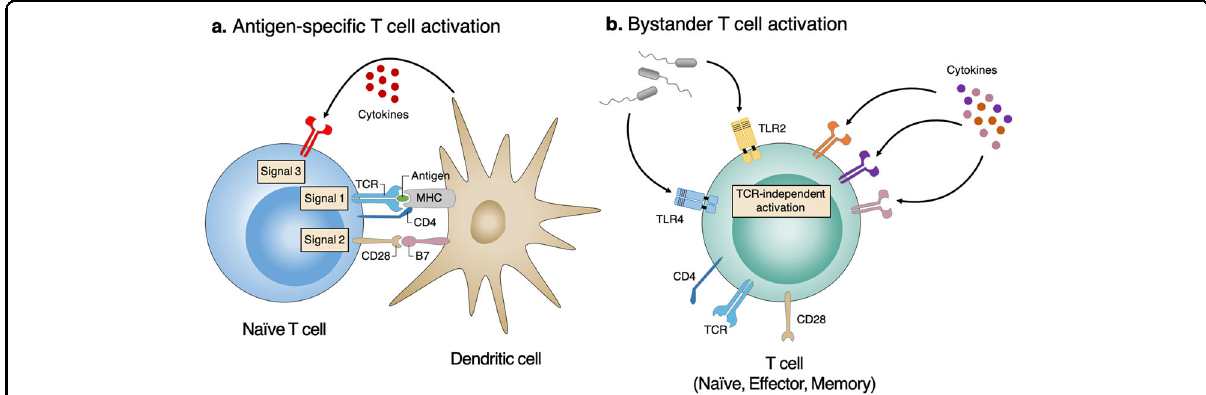
Fig. 1 Antigen-speci fi c vs. bystander T-cell activation. a Antigen-speci fi c T-cell activation requires three distinct signals. Signal 1 is antigen-speci fi c signaling mediated by T-cell receptor (TCR) engagement of pathogenic peptides presented by major histocompatibility complex (MHC) molecules. Signal 2 is costimulatory signaling, which is mainly mediated by the interaction of CD28 with one of the B7 molecules (CD80 and CD86). Signal 3 is polarizing signaling mediated by various cytokine milieus produced by dendritic cells. b In contrast, bystander T-cell activation is the concept of T-cell activation independent of antigen stimulation. Bystander-activated T cells can respond rapidly to in fl ammatory mediators (cytokine and TLR signaling) in a TCR-independent manner. TLR2 Toll-like receptor 2, TLR4 Toll-like receptor